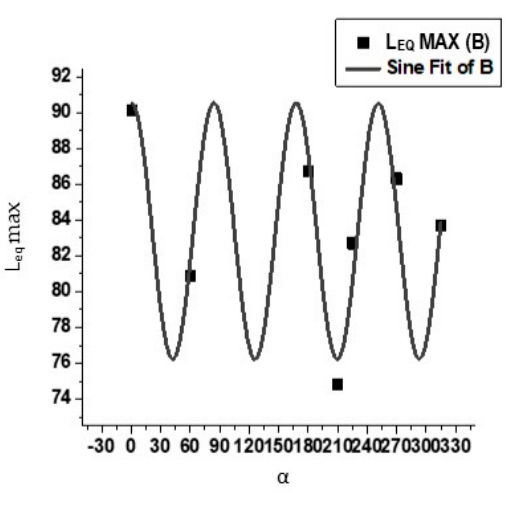
Figure 7. Maximum L eq at OS-T[9].